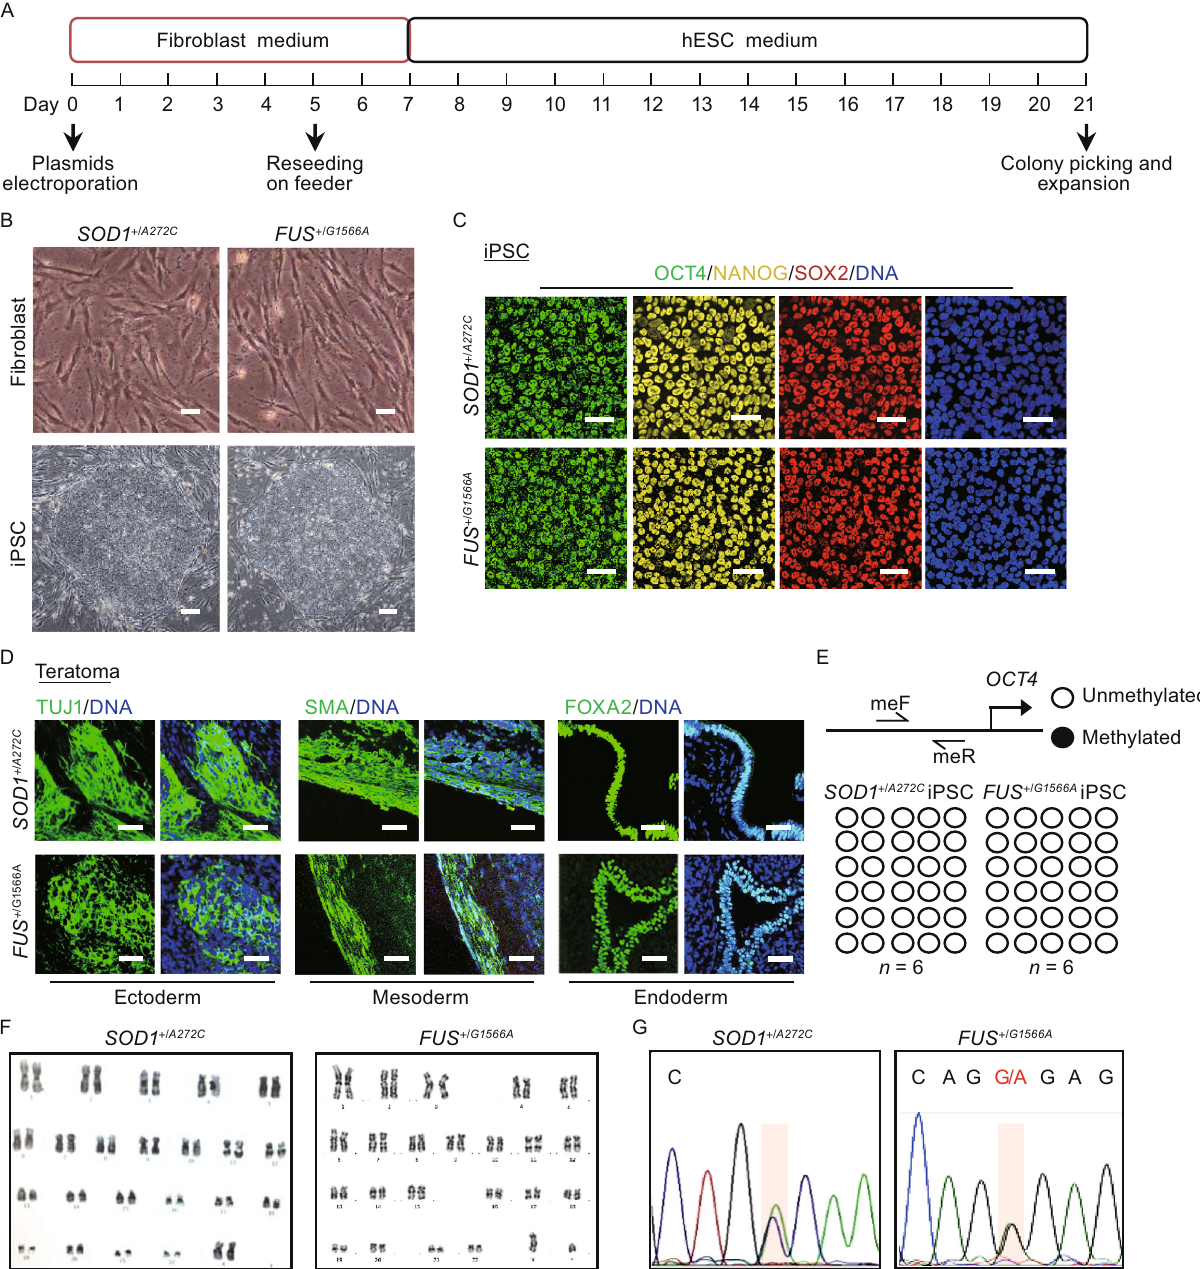
Figure 1. Establishment of SOD1 +/ A272C iPSCs and FUS +/ G1566A iPSCs. (A) Schematic procedure of generating iPSCs from ALS patient fi broblasts. (B) Phase-contrast images of ALS patient fi broblasts (top panels) and iPSCs (bottom panels). Scale bars = 25 µm (top bottom) and 100 μ m (bottom panels). (C) Immuno fl uorescent staining of pluripotency markers, OCT4, NANOG, and SOX2. Nuclei were stained with Hoechst 33342 (blue). Scale bars = 50 μ m. (D) Immuno fl uorescent staining of TUJ1 (ectoderm), SMA (mesoderm), and FOXA2 (endoderm) in teratomas derived from ALS iPSCs in vivo . Nuclei were stained with Hoechst 33342 (blue). Scale bars = 50 μ m. (E) DNA methylation analysis of the OCT4 promoter in ALS iPSCs. A pair of primers used is shown as arrows. Open and closed circles indicate unmethylated and methylated CpG dinucleotides respectively, as indicated. (F) Karyotyping analysis of ALS patient iPSCs. (G) Con fi rmation of the heterozygous mutation of SOD1 +/ A272C and FUS +/ G1566A in ALS iPSCs by DNA